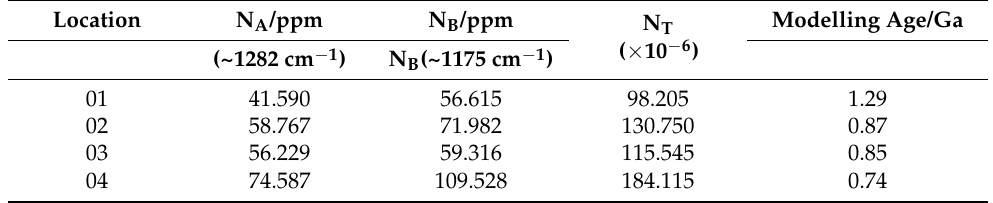
Table 4. Calculation of N concentration and t MR